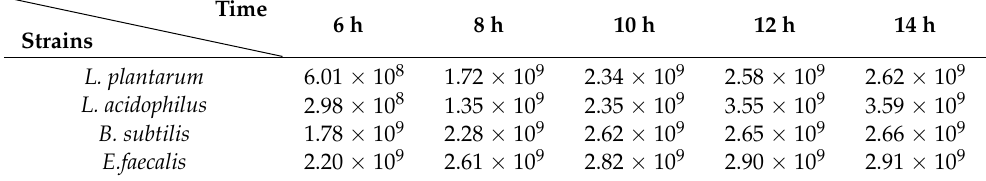
Table 2. Bacterial concentration results.